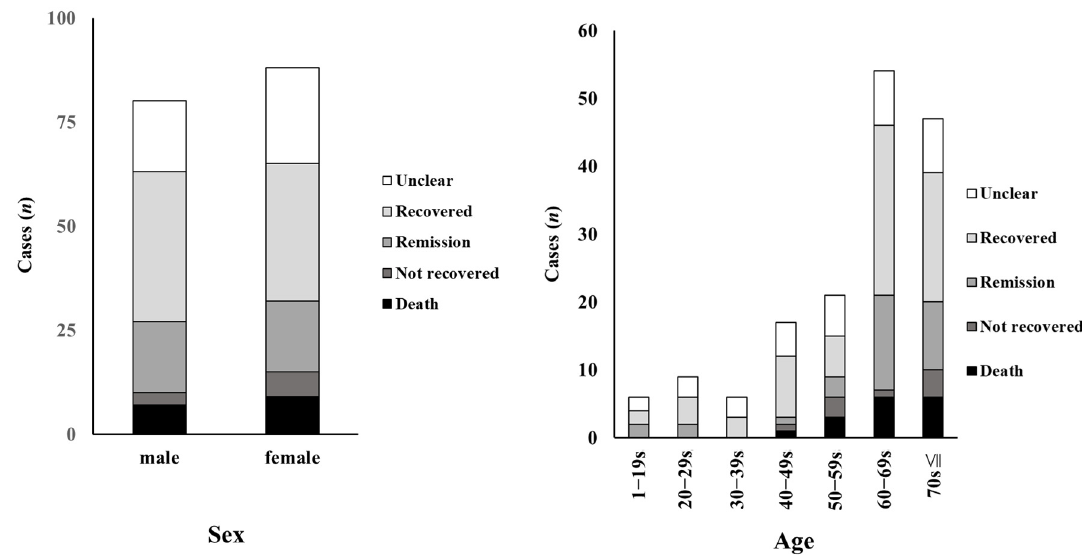
Figure 2. Analysis of age and outcomes in cases with dasatinib-associated gastrointestinal hemor- rhage. The outcome profiles of cases with dasatinib-associated gastrointestinal bleeding are sum- marized according to sex, age, and outcome.